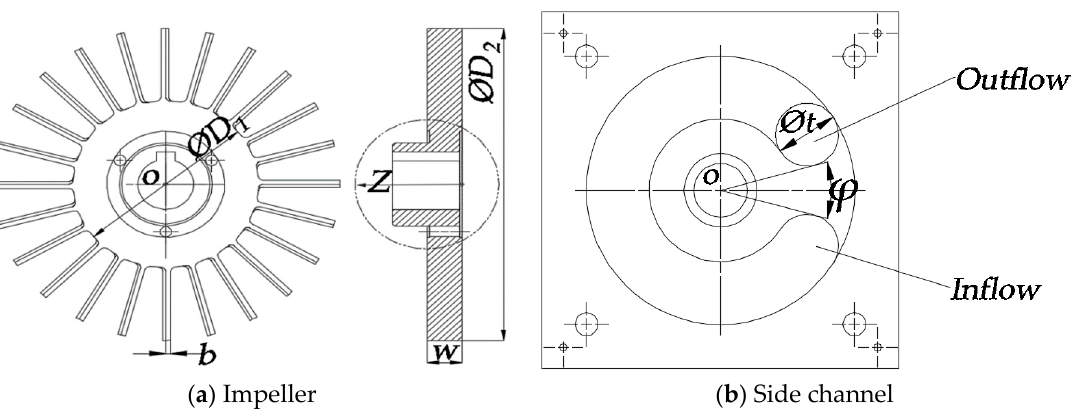
Table 1. Main geometrical parameters.